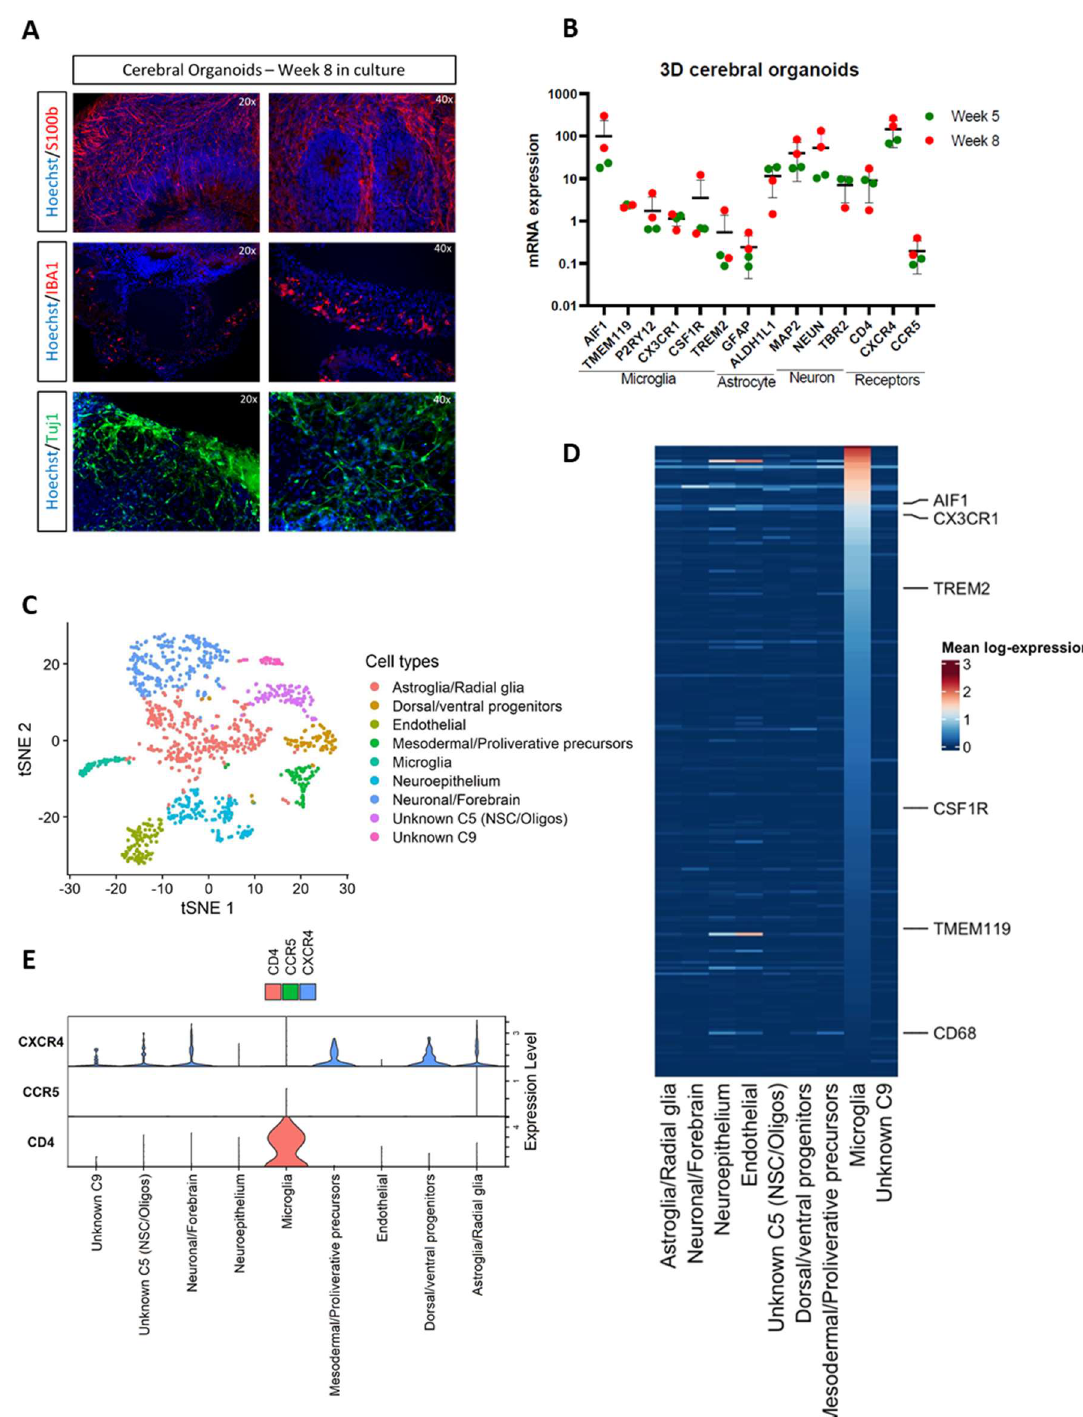
Figure 1. Cerebral organoids exhibit microglia, astrocyte, and neuronal cells and express HIV receptors. ( A ) Double immunostainings of S100b (astrocyte), IBA1 (microglia), and Tuj1 (neurons) combined with nuclear staining Hoechst after 8 weeks in culture. Representative pictures of cerebral organoids from iPSC line OH1.5 are shown. Magnification of 20 × and 40 × was used. ( B ) mRNA expression levels of microglia, astrocyte, and neuron-specific markers and HIV receptors were assessed by qRT-PCR. Gene expression was normalized to the reference gene ACTB. The means ± standard errors of the means are shown. ( C-E ) SORT-seq data of LPS-stimulated organoids after 9- 10 weeks in culture. ( C ) Annotated clusters on tSNE plot. Cluster 5 (C5) was only partially anno- tated. Cluster 9 (C9) was not annotated. ( D ) Heatmap of Patir et al. (2019) microglia signature gene